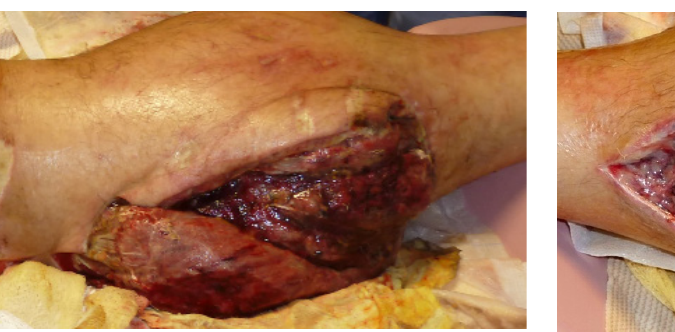
Figure 2. The lateral calf wound post-HBOT shows improvement in the edema and evidence of tissue